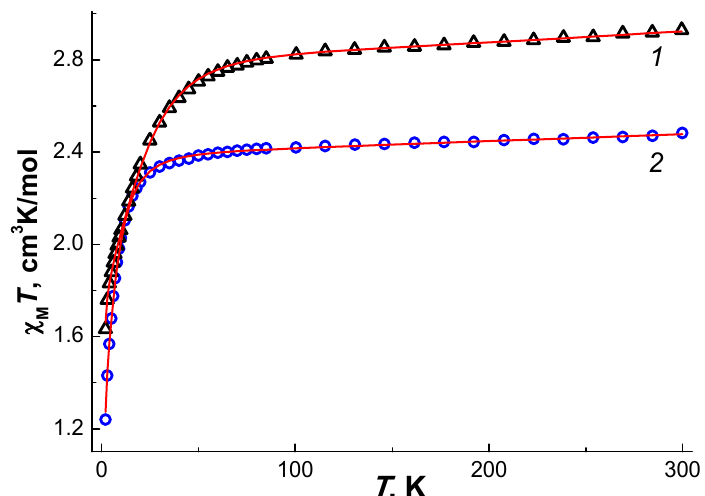
Figure 2. Temperature dependences χ m T of complexes I ( 1 ) and II ( 2 ) ( H = 5 kOe). Lines are the result of approximation of experimental data with Equation (1) (see text).